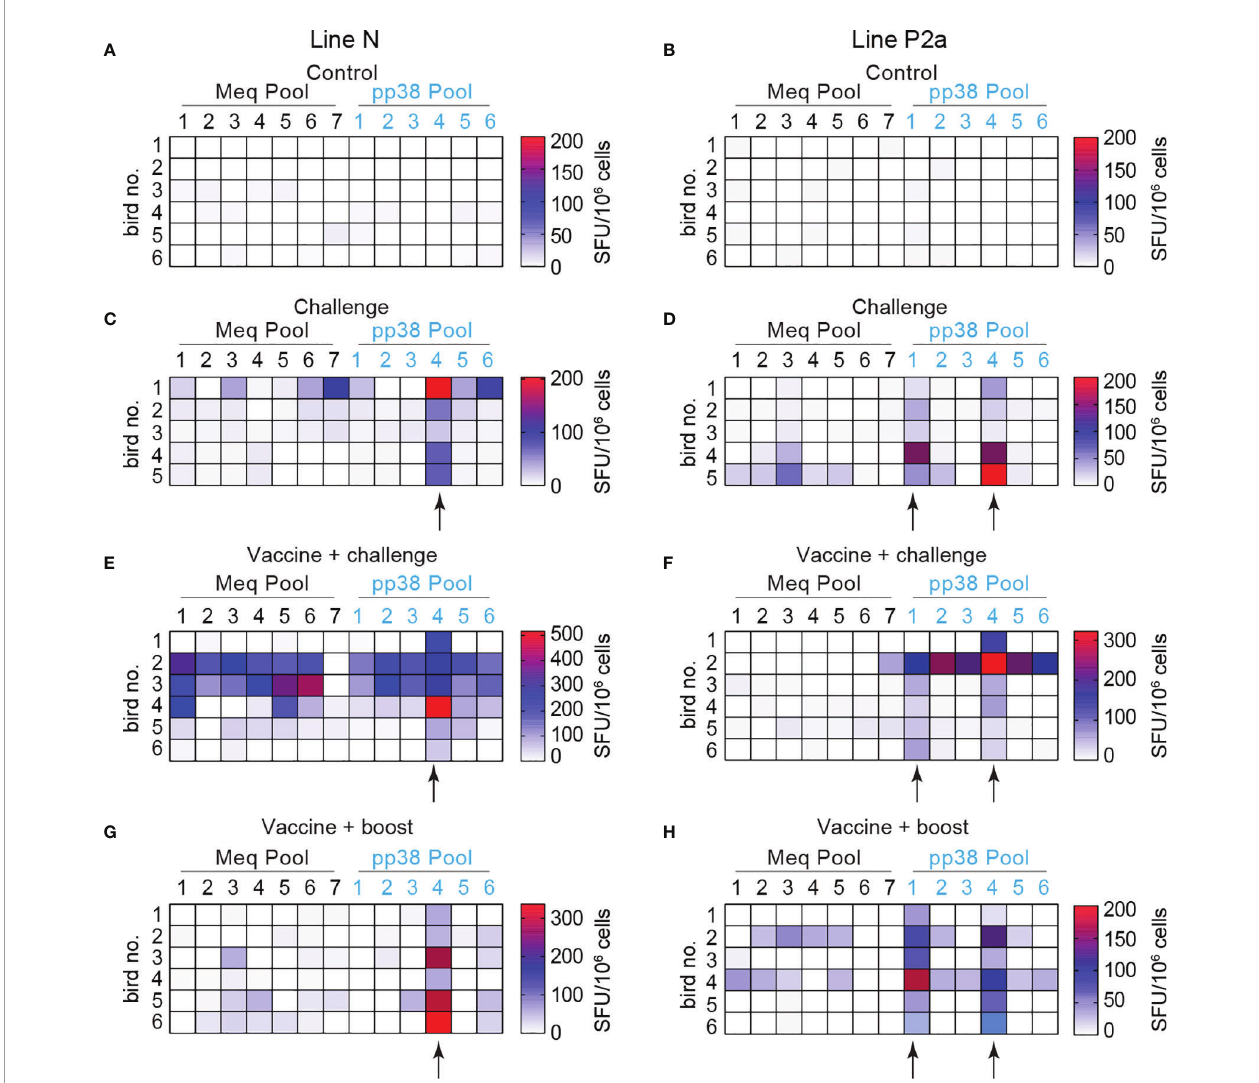
FIGURE 7 | Expanded breadth of effector T cells in vaccine-challenge group of line N chickens. Splenocytes were isolated 2 weeks after the last inoculation from the experimental groups; control (A, B) , challenge (C, D) , vaccine-challenge (E, F) and vaccine-boost (G, H) from both line N and P2a chickens. The frequencies of IFN-gamma producing T cells recognizing 7 different peptide pools spanning entire MEQ and 6 different peptide pools spanning entire pp38 were determined using an ex vivo chIFN-gamma ELSIPOT assay and the results are presented as a heat map. Black arrows indicate the peptide pools with potential immunodominant epitopes. All ELISPOT assays were performed in triplicates and results are representative of 5 – 6 chickens within each experimental group from each chicken line. Arrows shows the peptide pools from pp38 derived peptides activating IFN-gamma production from splenocytes of most of the line N and line P2a chickens within the challenge, vaccine-challenge, and vaccine-boost